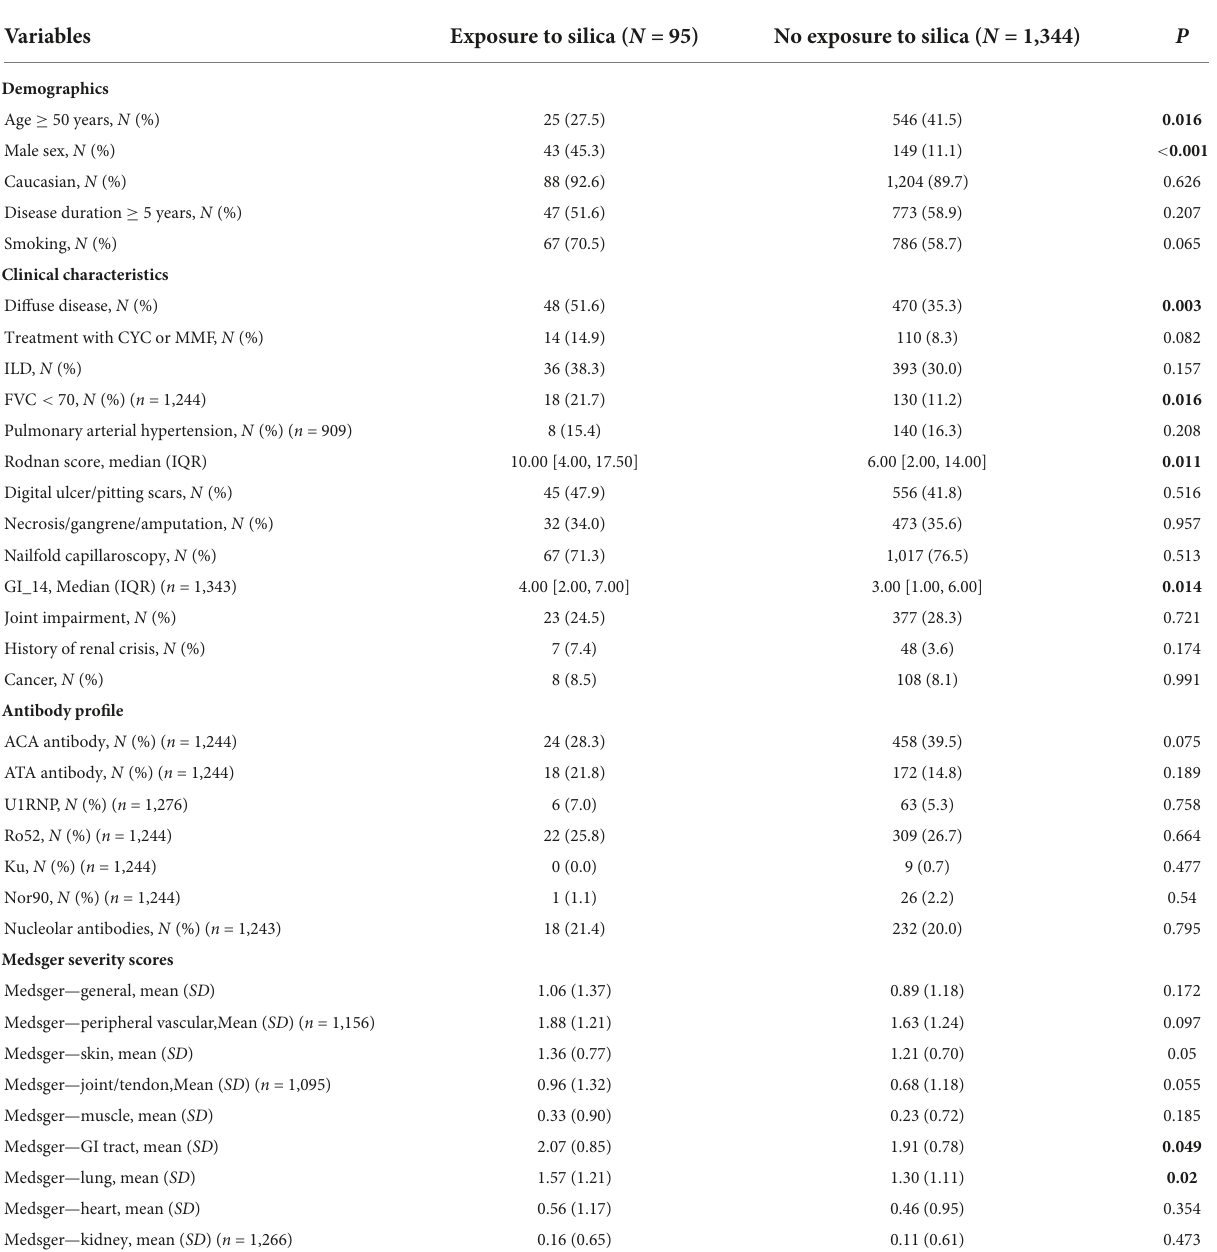
TABLE 1 Baseline patient